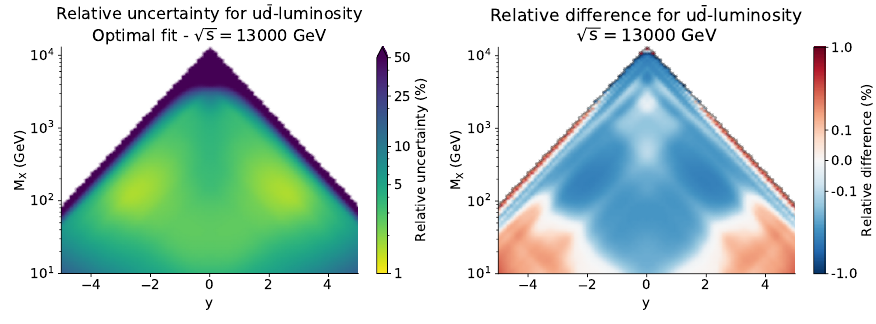
Figure 17 . Same as (cid:12)gure 16 but for the u (cid:22) d